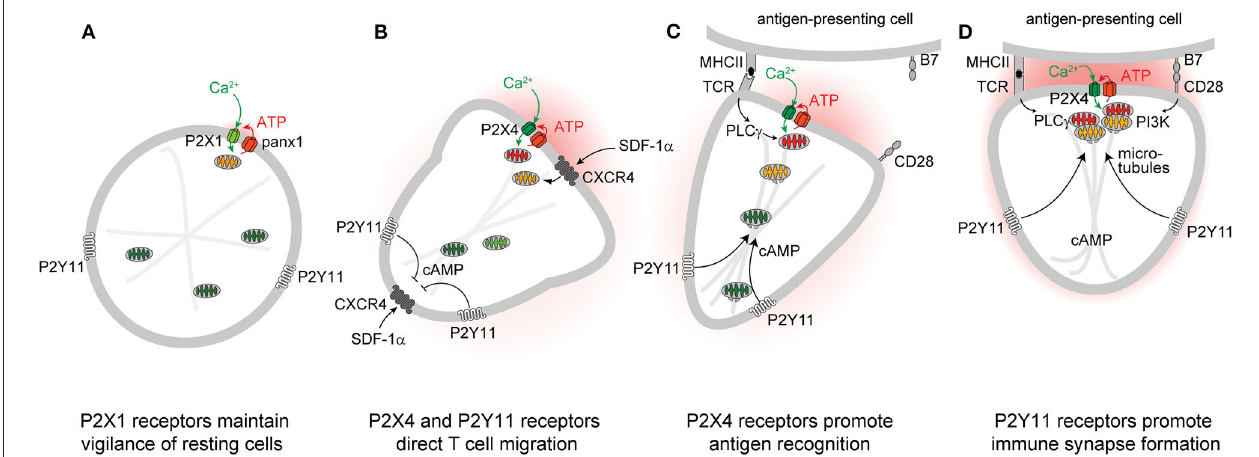
FIGURE 1 | P2 receptors and mitochondria regulate key T cell functions. Autocrine feedback through P2X1 receptors and low-level mitochondrial metabolism maintain a state of vigilance that quiescent T cells need for immune surveillance (A) . Chemokine receptors such as CXCR4 trigger mitochondrial metabolism that stimulates P2X4 and P2Y11 receptor-mediated excitatory and inhibitory Ca 2 + and cAMP signaling pathways that direct cell movement at the front and back of migrating T cells (B) . P2X4 receptor accumulation at the immune synapse enhances T cell receptor (TCR) signaling and promotes antigen recognition and the engagement of T cells with antigen-presenting cells (C) . P2Y11 receptor recruitment to the uropod of polarized cells induces cAMP/PKA signaling that helps direct the trafficking of mitochondria to the immune synapse (D)